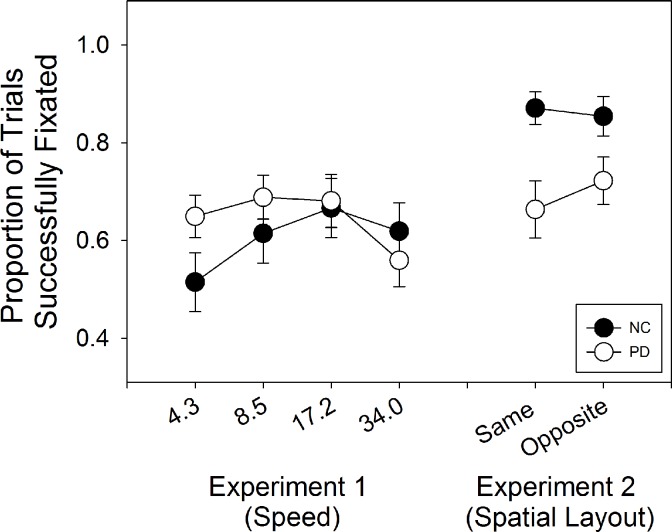
Proportion of trials fixated in Experiments 1 and 2.In Experiment 1, a significant interaction between group and stimulus speed emerged, and in Experiment 2, a main effect of group was present, with PD fixating successfully less frequently than NC.